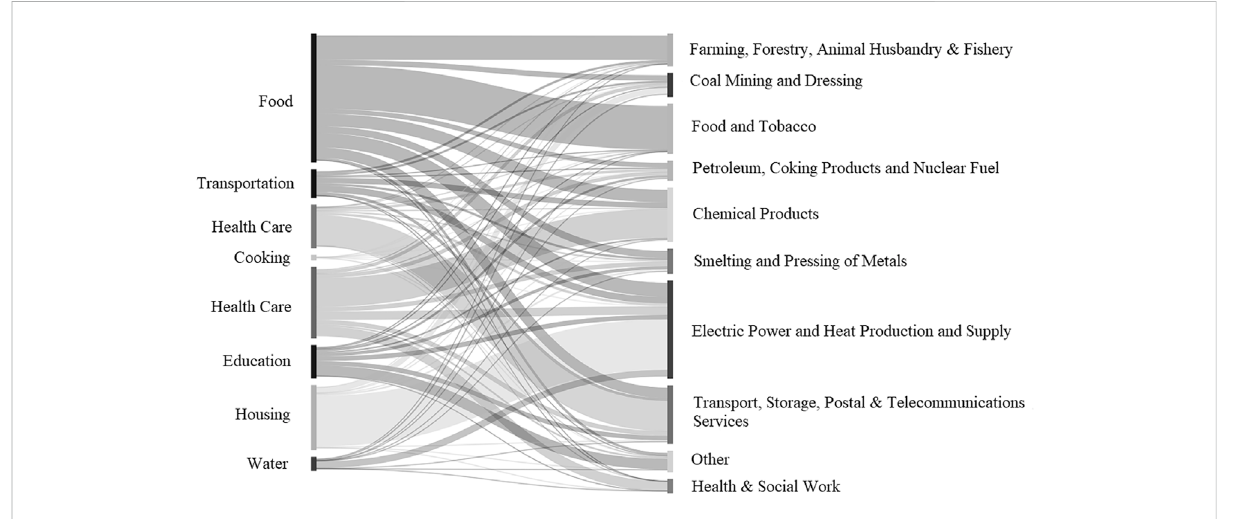
FIGURE 5 The path of residential indirect energy